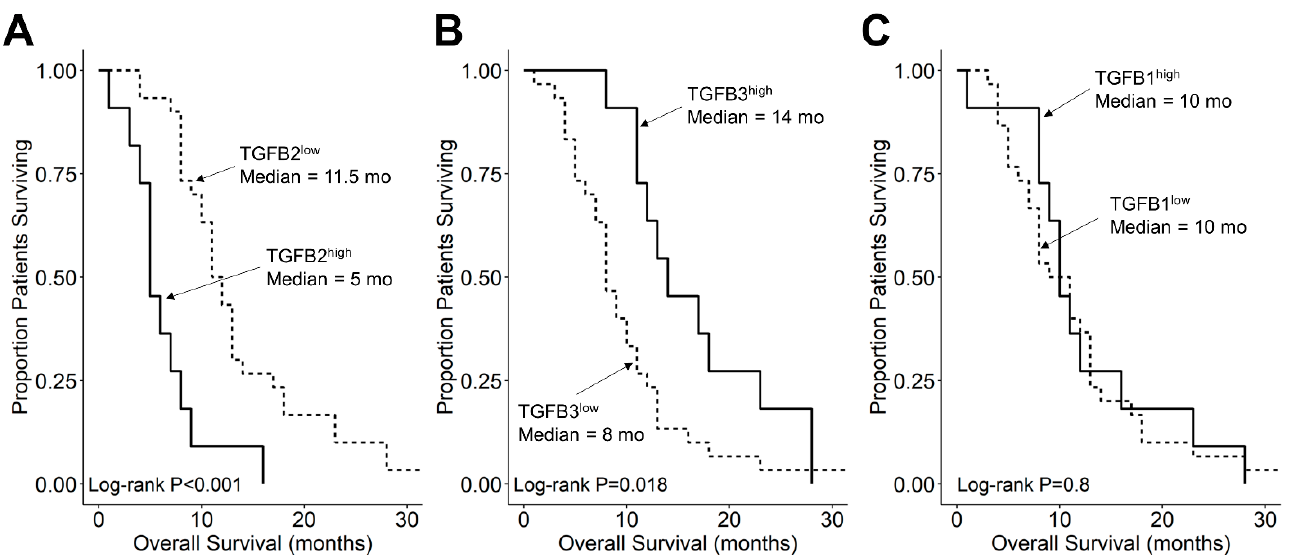
Figure 4. Amplified expression of TGFB2 is associated with shorter OS in DIPG patients. Archived survival outcome data for 41 DMG patients, including 11 DIPG patients with unknown H3K27M mutational status, 4 H3K27M-mutant DIPG patients and 26 H3K27M-mutant DMG patients, whose brain tumors were localized to pons/brainstem, obtained from cBioPortal for Cancer Genomics (https://pedcbioportal.kidsfirstdrc.org/) was combined with RNAseq-based mRNA expression data for of TGFB2 ( A ), TGFB3 ( B ), and TGFB1 ( C ) to assess the potential impact of the respective TGFB isoform levels on OS. Log 2 -transformed, TPM-normalized RNAseq values were rank-ordered according to expression level for each TGFB isoform. Patients whose expression levels for a given TGFB isoform was greater than or equal to the upper quartile (solid line) were compared to the remaining patients (dashed line). See the legend of Figure 1 for the TGFB isoform levels in the analyzed patient subsets. ( A ) The mean expression level for TGFB2 in the 11-patient TGFB2 high subset was 6.19 ± 0.24 (median, range = 5.81, 5.23–7.63). By comparison, the mean TGFB2 expression level for the 30-patient TGFB2 low subset was 3.22 ± 0.23 (median, range = 3.48, − 0.42–5.07). Patients with high TGFB2 mRNA expression (TGFB2 high ) exhibited a significantly worse OS outcome than rest of the patients (TGFB2 low ) (median OS for TGFB2 high subset: 5 months, 95% CI: 5–NA months, 11 events, N = 11); median OS for TGFB2 low subset: 11.5 months, 95% CI: 10–14 months, 30 events, N = 30; log-rank chi-square = 16.2, p = 5.6 × 10 − 5 ). ( B ) The mean expression level for TGFB3 in the 11-patient TGFB3 high subset was 4.7 ± 0.2 (median, range = 4.6, 4–5.6). By comparison, the mean TGFB3 expression level for the 30-patient TGFB3 low subset was 3 ± 0.1 (median, range = 3.1, 1.5–4). Patients with high TGFB3 expression (TGFB3 high ) (median OS: 14 months, 95% CI: 12–NA months, 11 events, N = 11) exhibited a significantly better OS outcome than TGFB3 low patients (median OS: 8 months, 95% CI: 7–11 months, 30 events, N = 30; log-rank chi-square = 5.6, p = 0.018). (C) The mean expression level for TGFB1 mRNA in the 11-patient TGFB1 high subset was 4.8 ± 0.1 (median, range = 4.8, 4.5–5.4). By comparison, the mean TGFB1 expression level for the 30-patient TGFB1 low subset was 3.8 ± 0.1 (median, range = 3.9, 1–4.5). Patients with high TGFB1 expression (TGFB1 high ) (median OS = 10 months, 95% CI: 9–NA months, 11 events, N = 11) exhibited similar OS outcomes when compared to the rest of the patients (TGFB1 low ) (median OS = 10 months, 95% CI: 8–13 months, 30 events, N = 30; log-rank chi-square = 0.1, p = 0.8).